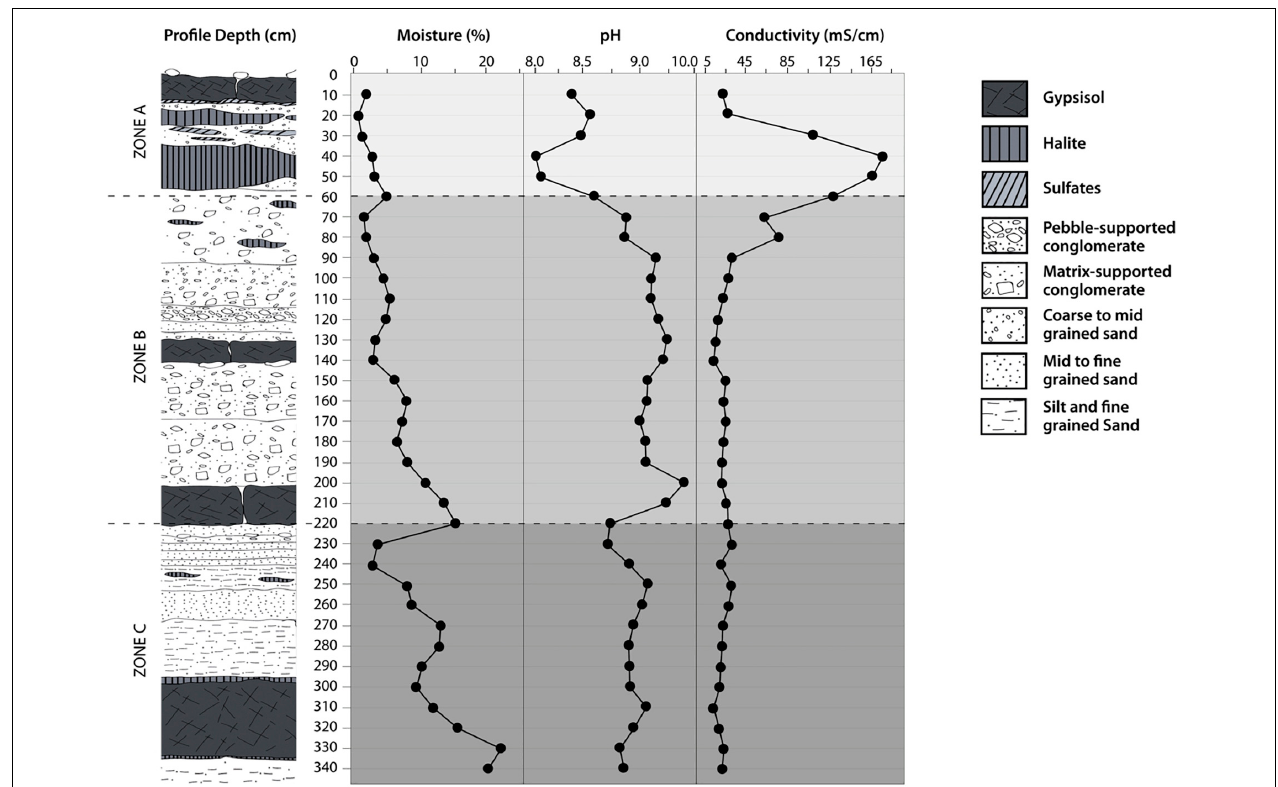
FIGURE 3 | Distribution of the soil profile parameters at the Yungay site in the Atacama Desert. Moisture content (%), pH value and electric conductivity